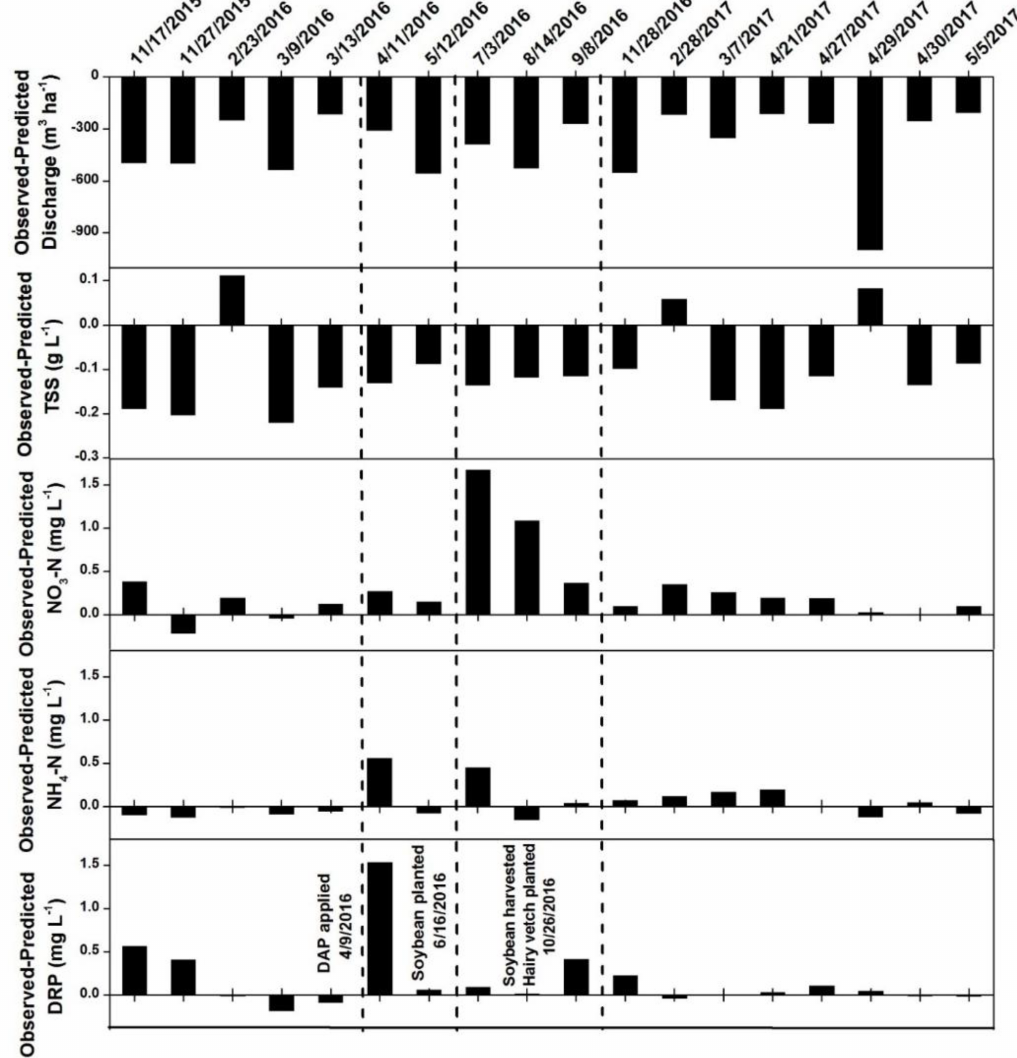
Figure 6. Observed minus predicted discharge, total suspended solids (TSS), NO 3 -N, NH 4 -N, and dissolved reactive phosphorus (DRP) from the CC-treatment